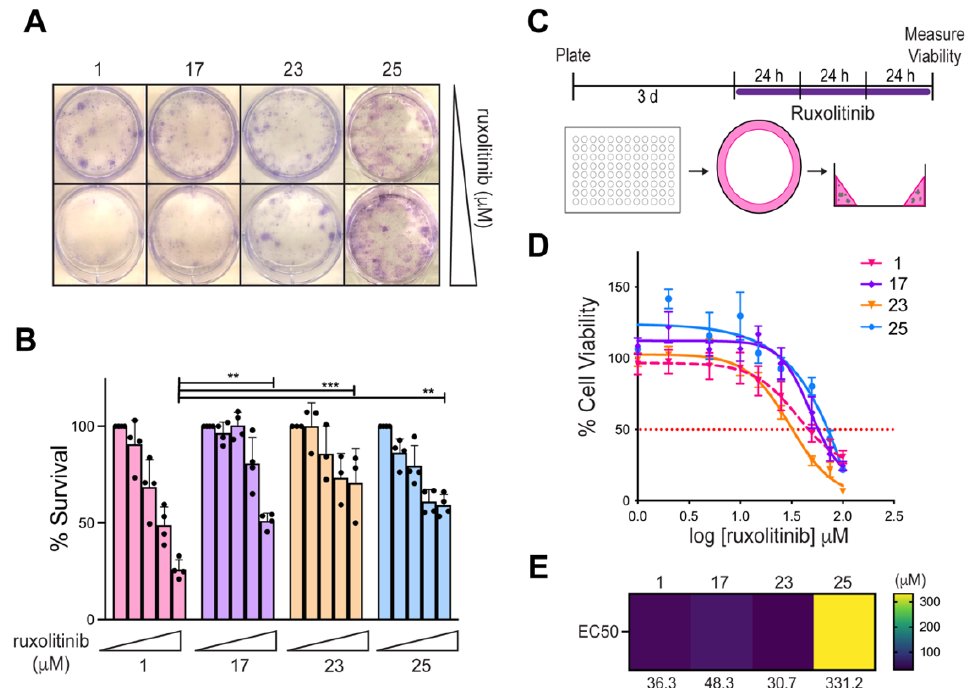
Figure 5. Predicted sensitivity to ruxolitinib was functionally validated. ( A ) Representative clono- genic assay images for 0 and 100 μ M ruxolitinib treatment. ( B ) Graph of percent survival of colonies after treatment with ruxolitinib at each of the assayed drug concentrations. Where a colony was only scored if it consisted of at least 25 cells. At least three biological replicates were performed for each cell line, and a significant difference in percent survival between cell lines was determined for 100 µ M ruxolitinib treatment using a one-way ANOVA, where ** is p ≤ 0.01 and *** is p ≤ 0.001. ( C ) Treatment scheme for the patient-derived organoid screening method used. ( D ) Dose-response graphs of the PDO panel. Percent viability was plotted over the log of ruxolitinib concentration to generate EC50 values for each cell line (shown in ( E )). The red dotted line indicates 50% viability. Each patient ‐ derived organoid drug screen was performed in at least three biological replicates.